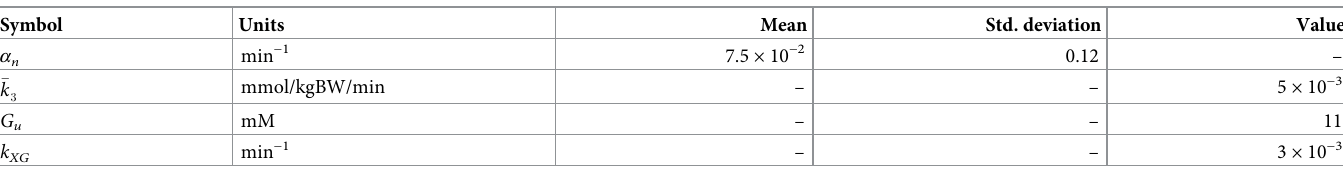
Table 1. Changed parameter values of the Extended Model with respect to [17].